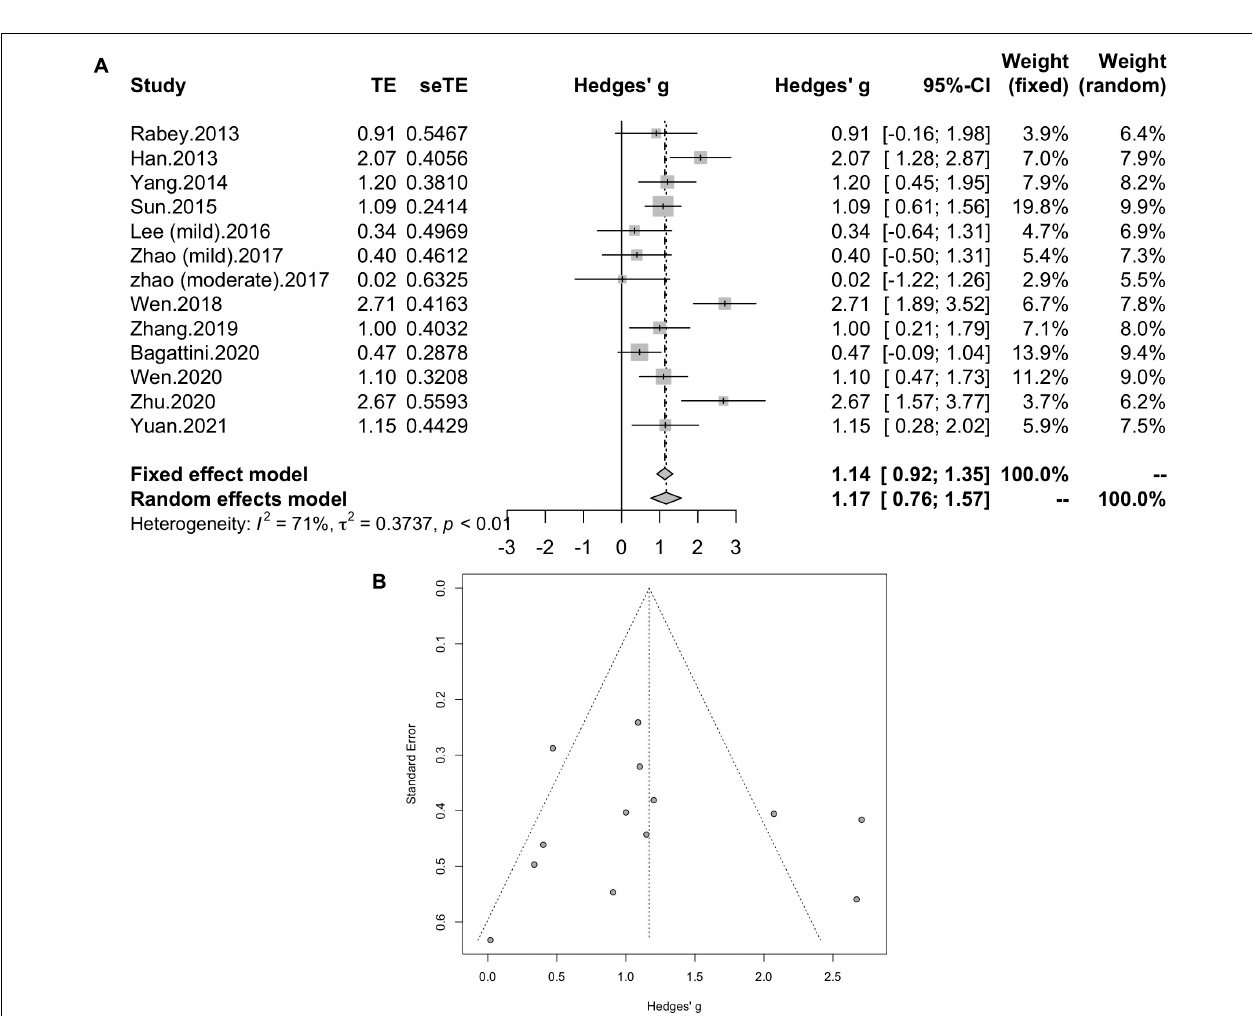
FIGURE 3 | (A) Forest plot: mean differences in effect of rTMS on different cognitive domain in patients with MCI or early AD with 95% CI. (B) Funnel plot for the publication bias of global cognitive function.